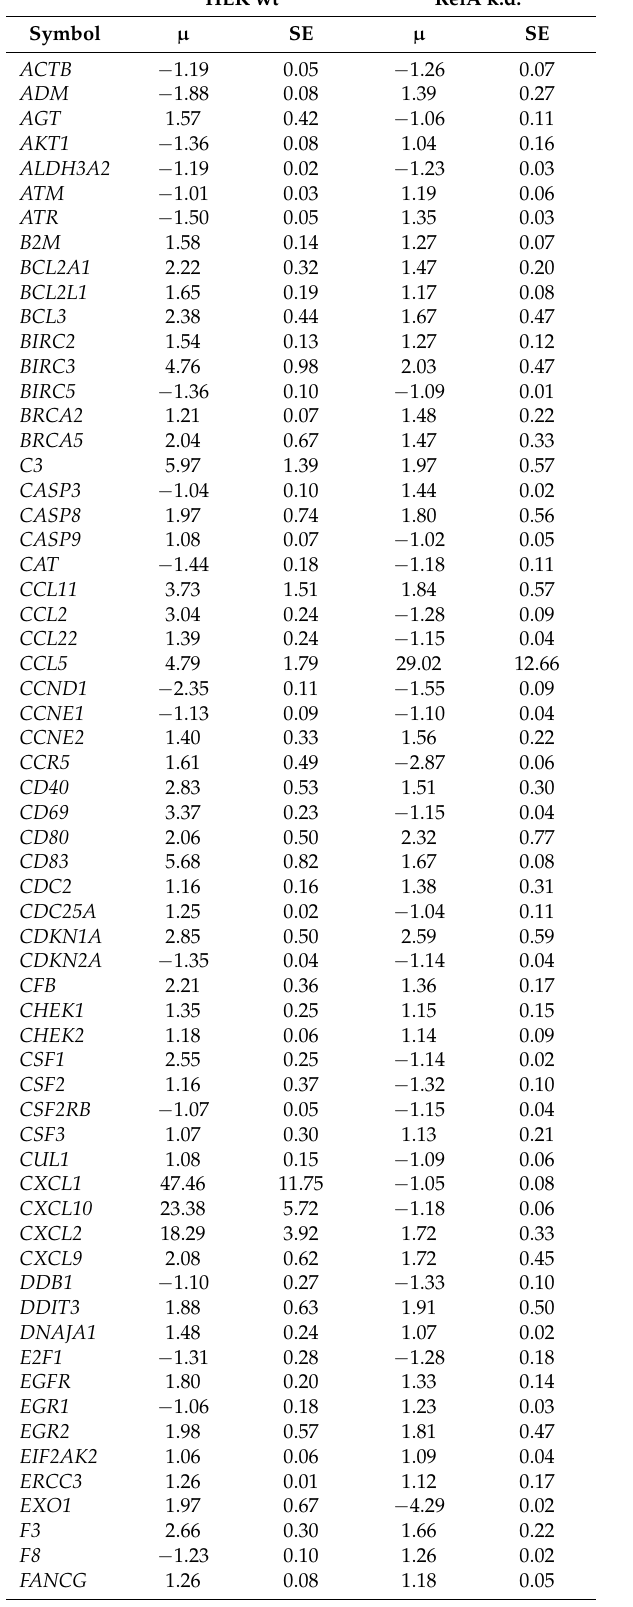
Table A4. TNF- α induced gene expression in HEK shRNA RelA cells (RelA k.d.) compared to